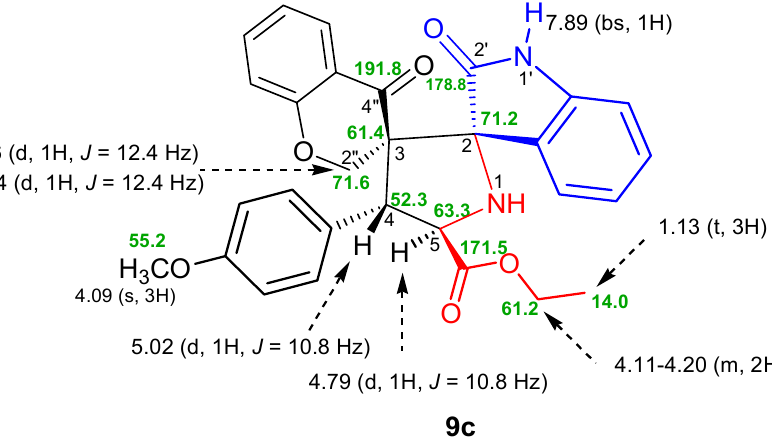
Figure 3. 1 H (black) and 13 C { 1 H} NMR (green) chemical shifts (ppm) of the selected compound 9c (see also Figure S20 in the Supporting Material).